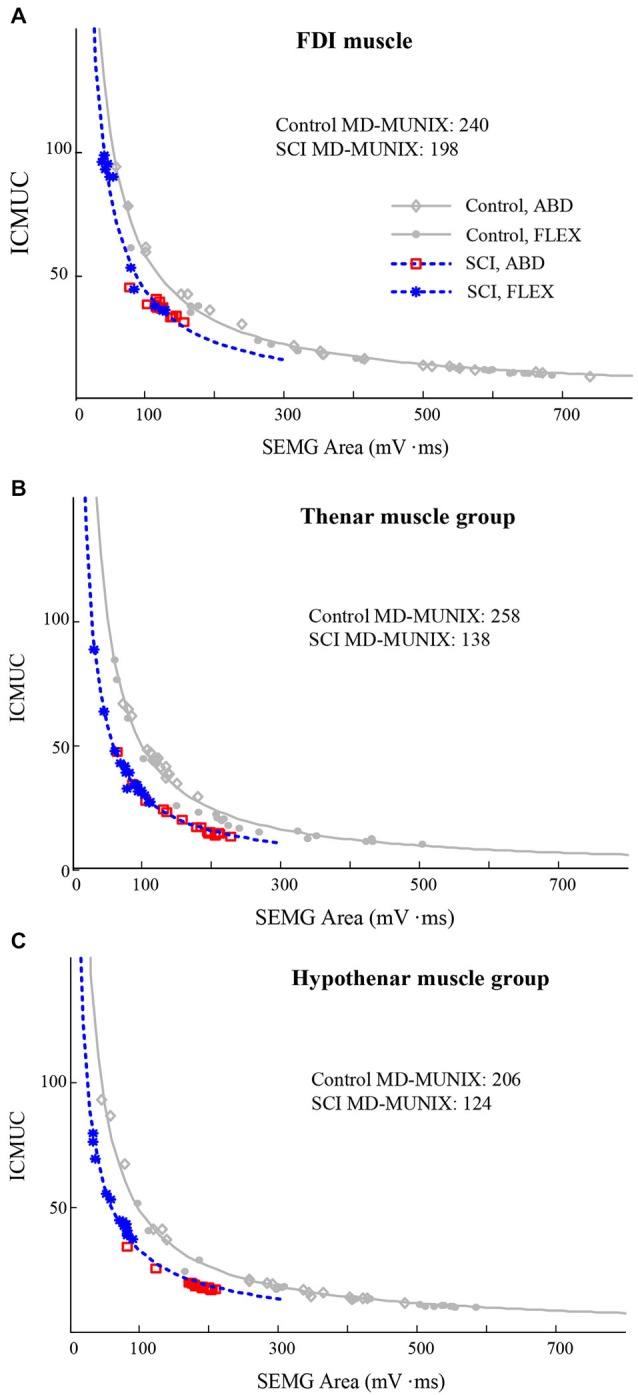
Examples of MD-MUNIX calculation in representative SCI and healthy control subjects. The MD-MUNIX was derived using the CMAP and the voluntary surface EMG in both abduction (ABD) and flexion (FLEX) modes for the curve fitting. (A) the FDI muscle; (B) the thenar muscles; (C) the hypothenar muscles.